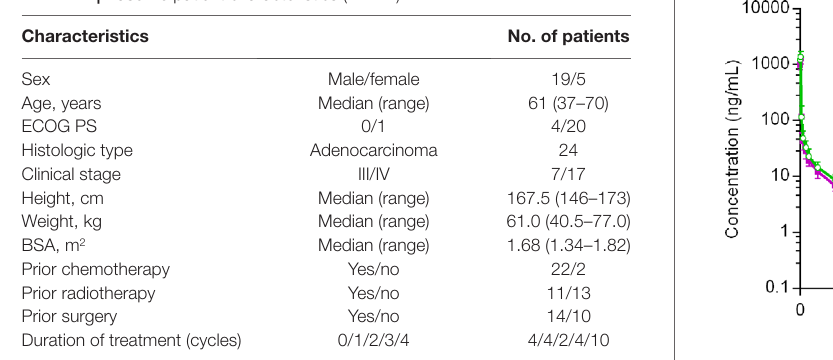
TABLE 1 | Baseline patient characteristics ( n = 24).